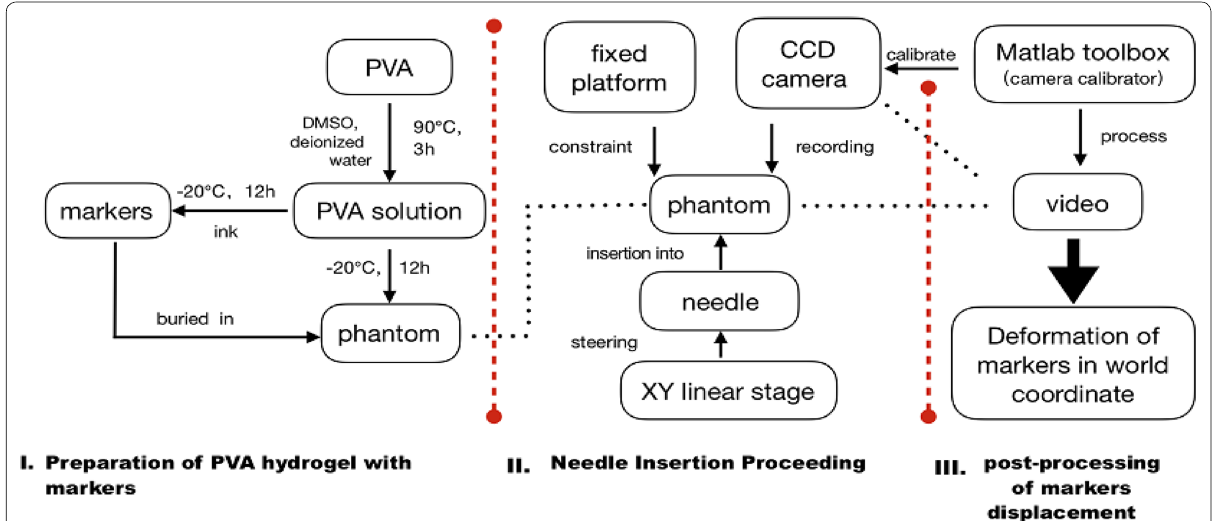
Figure 3 A completed needle insertion proceedings